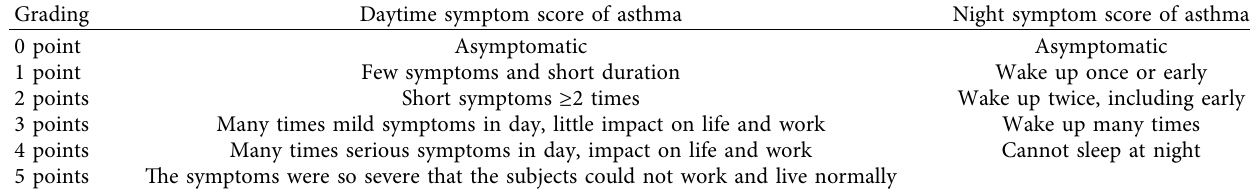
Table 2: Evaluation of daytime and night symptoms of asthma.